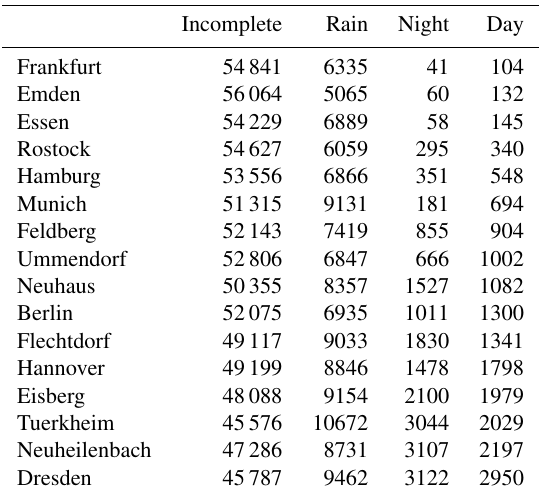
Table 1. Number of hourly incomplete, rainy, nighttime, and com- plete daytime hourly radar images per station. The top four radars are excluded from further